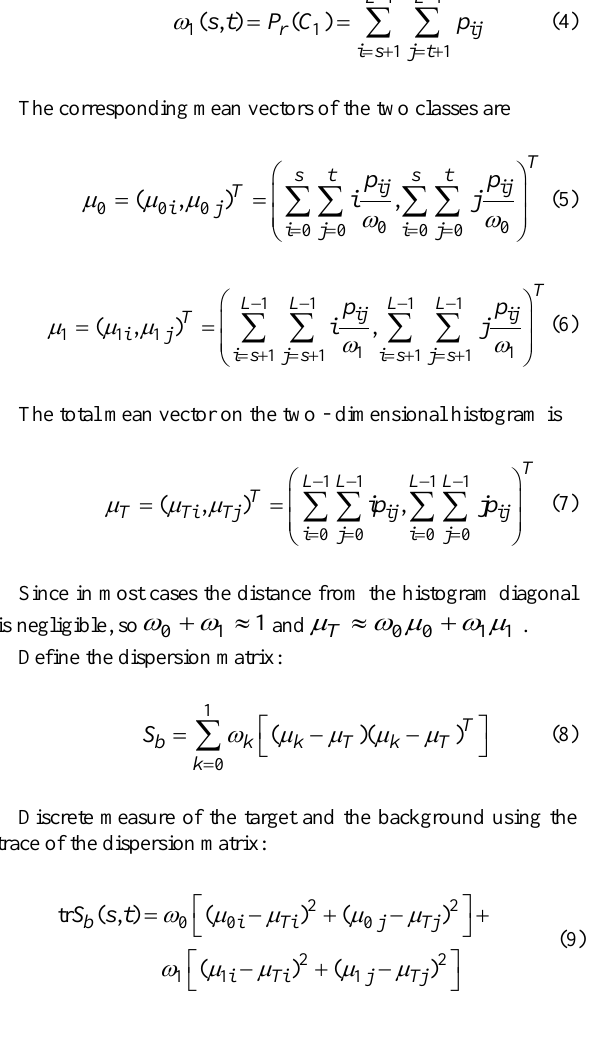
Fig. 2. Gray image and its two-dimensional